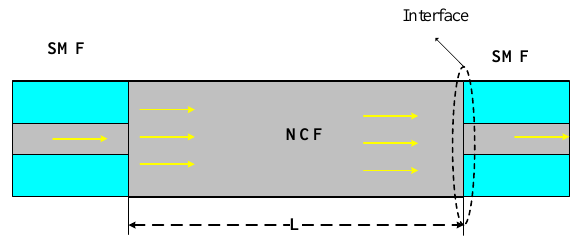
Figure 1. Schematic diagram of the single-mode-no-core-single mode fiber (SNCS)